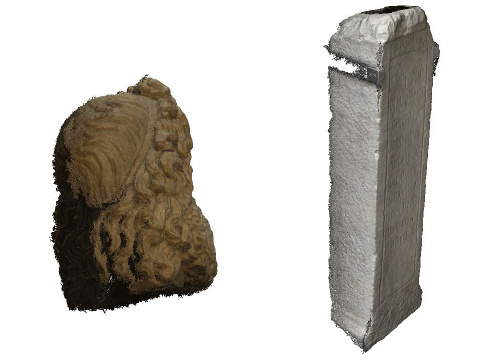
Figure 3 Two examples of objects blocked on a wall: a head (left) and a stele (right).